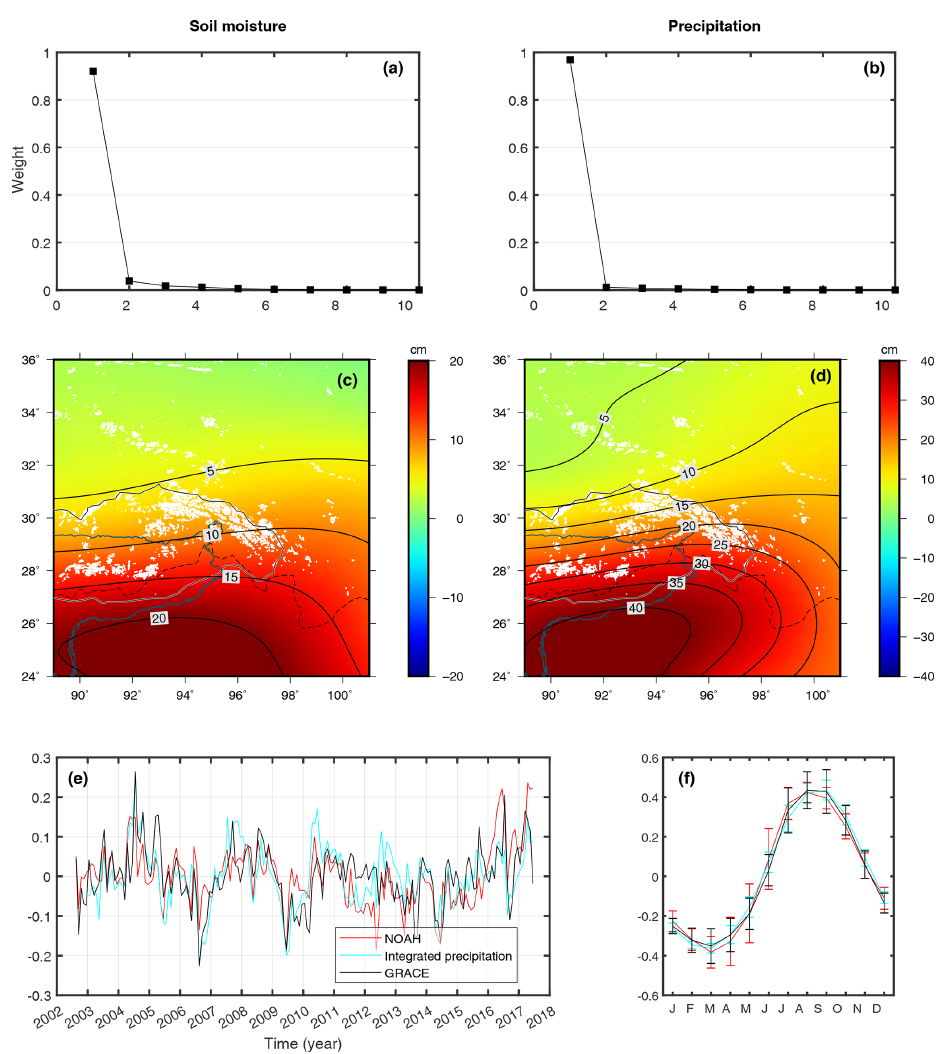
Figure 5. EOF analysis of soil moisture using GLDAS Noah (a, c) and of precipitation using TRMM (b, d) . The weights of the first 10 modes are shown in the upper panels (a, b) . The first EOFs and PCs are shown in the middle and bottom panels (c–f) . The PCs are separated into detrended interannual (e) and annual (f) variations for better